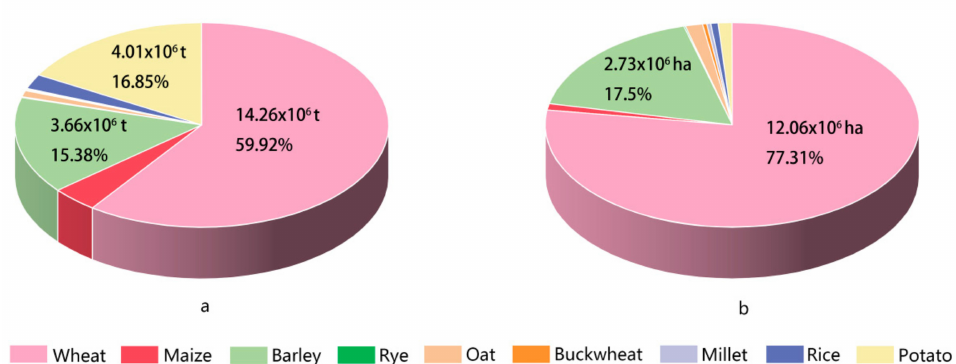
Figure 2. Kazakhstan’s food structure. (( a ). food productions; ( b ). harvested